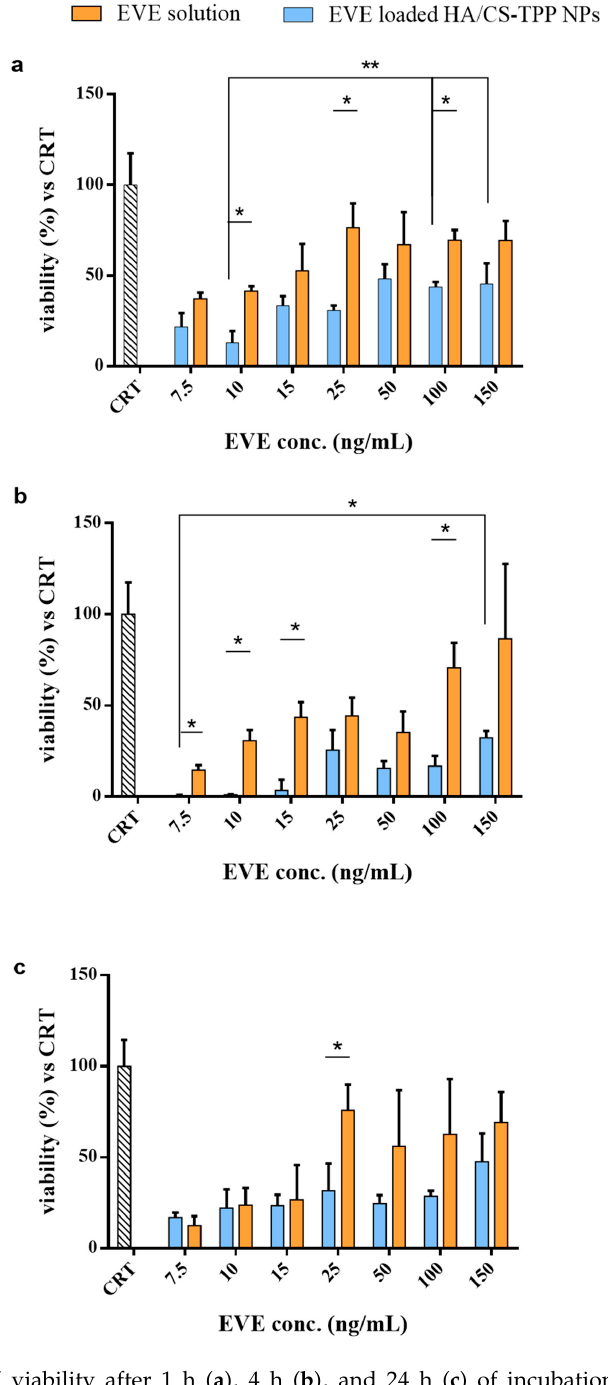
Figure 5. NHDFs’ viability after 1 h ( a ), 4 h ( b ), and 24 h ( c ) of incubation with EVE loaded HA/CS-TPP NPs (dark bar), EVE solutions (grey bar), and untreated control ([CRT], striped bar) cells. Statistical significance was determined using the Holm–Sidak method (multiple t test), with α < 0.05 (*). Tukey’s multiple comparisons test reveals a significant difference (*) for p values < 0.05 and (**) for p values < 0.01.